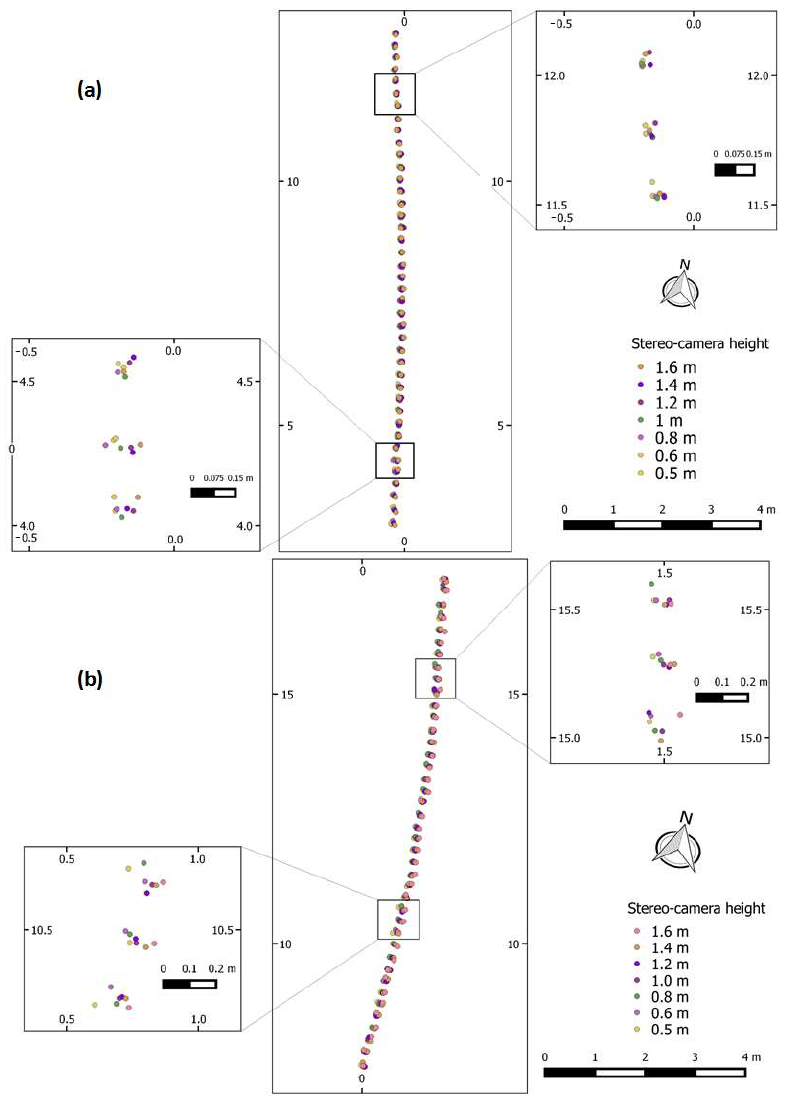
Figure 3. ( a ) Diagram showing the track followed along the 10 m reach at the Chicheley Brook (Cranfield, UK) for the stereo-camera calibration study; and ( b ) diagram showing the track followed along the 10 m reach at the River Ouzel site (Ouzel Valley Park, UK). Each stereo-camera height setting has been depicted with a different colour. The zoomed images show the precision in track replicability. All coordinates reported are local. Each of the points shows were stereo-imagery were collected for each of the height settings.